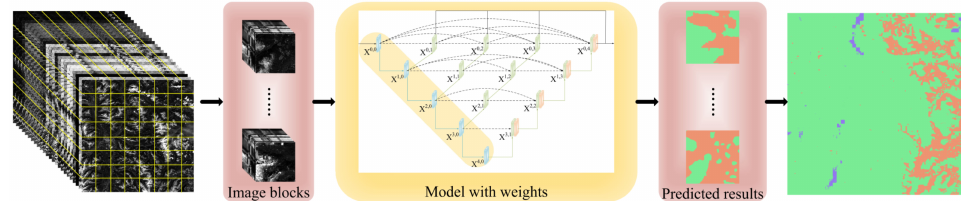
Figure 8. The process of the prediction of the entire Sentinel-2 image.